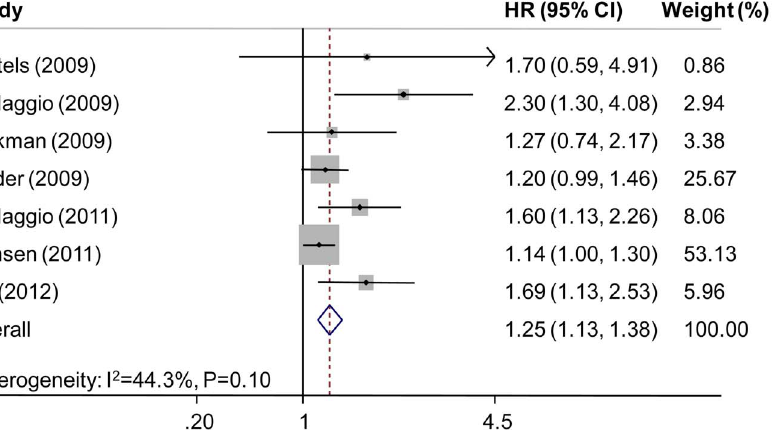
Figure 2. Individual study and overall hazard ratios of relationships between general anesthesia and neurodevelopmental impairment in children. The size of each square is proportional to the weight of the study. For the combined result, the length of the diamond represents the 95% CI of the summary.